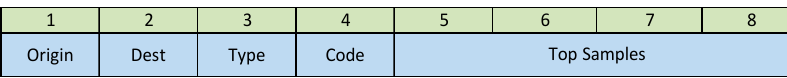
Figure 4. Structure of the Sampling Order message.